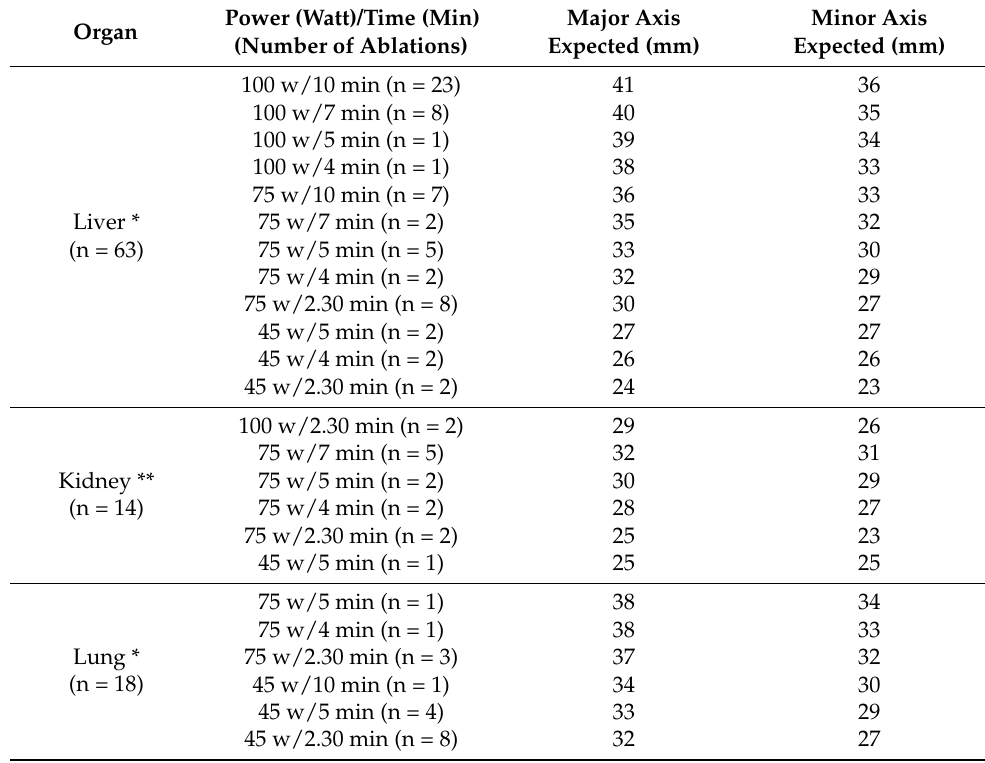
Table 1. Charts provided by the manufacturer for liver, kidney and lung ablations. Power (Watt)/Time Organ